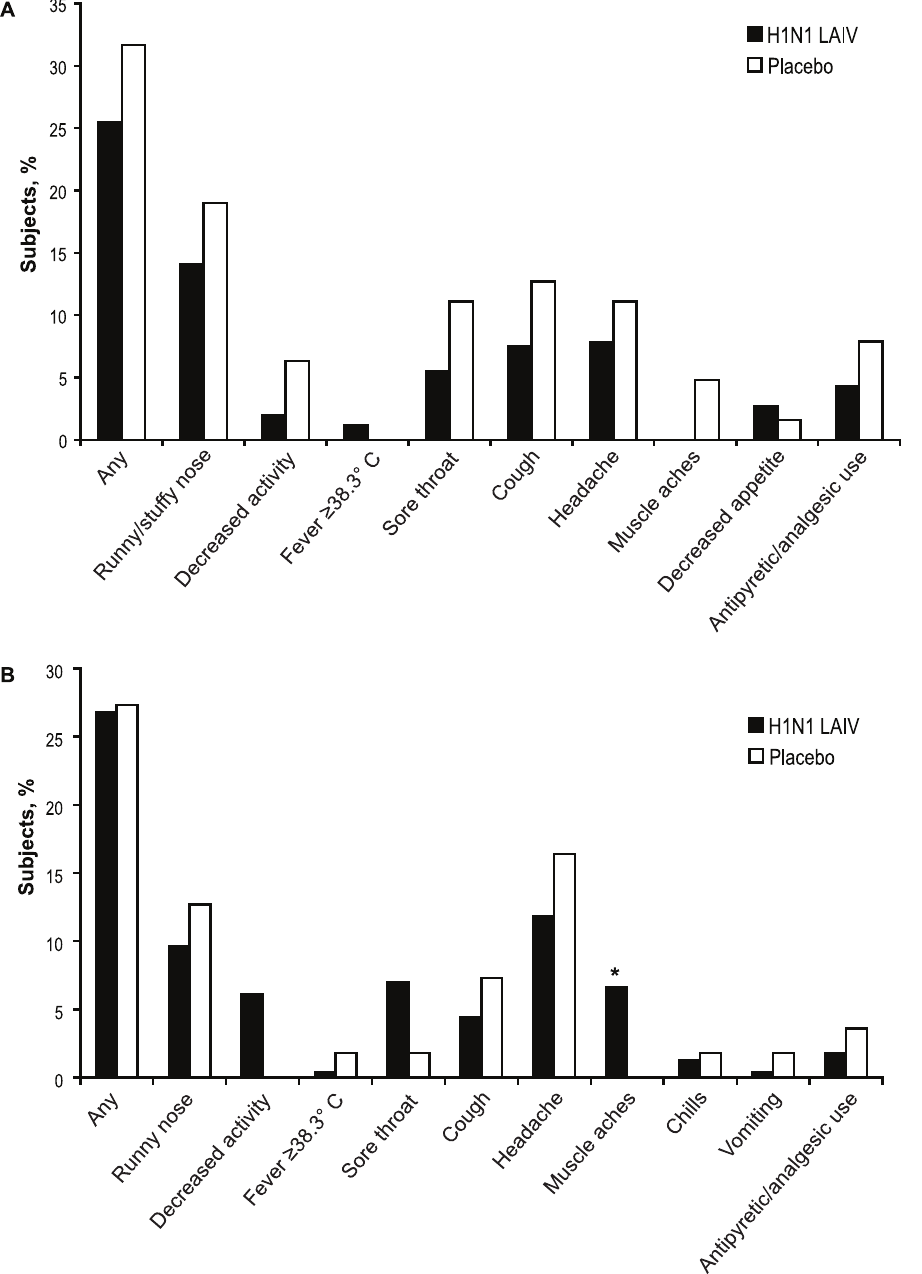
Figure 3. Solicited Symptoms in (A) Children and (B) Adults Through Day 8 Postvaccination with Dose 2. * P , 0.05. doi:10.1371/journal.pone.0013755.g003 25.4% and 20.0% of H1N1 LAIV and placebo recipients, respectively, after dose 1 and 11.8% and 16.4% through day 8 after dose 2. The rate of headaches in adults receiving H1N1 LAIV compared with placebo did not differ significantly. Through day 8 after dose 1 significantly more adults who received H1N1 LAIV experienced runny nose (H1N1 LAIV, 15.4%; placebo